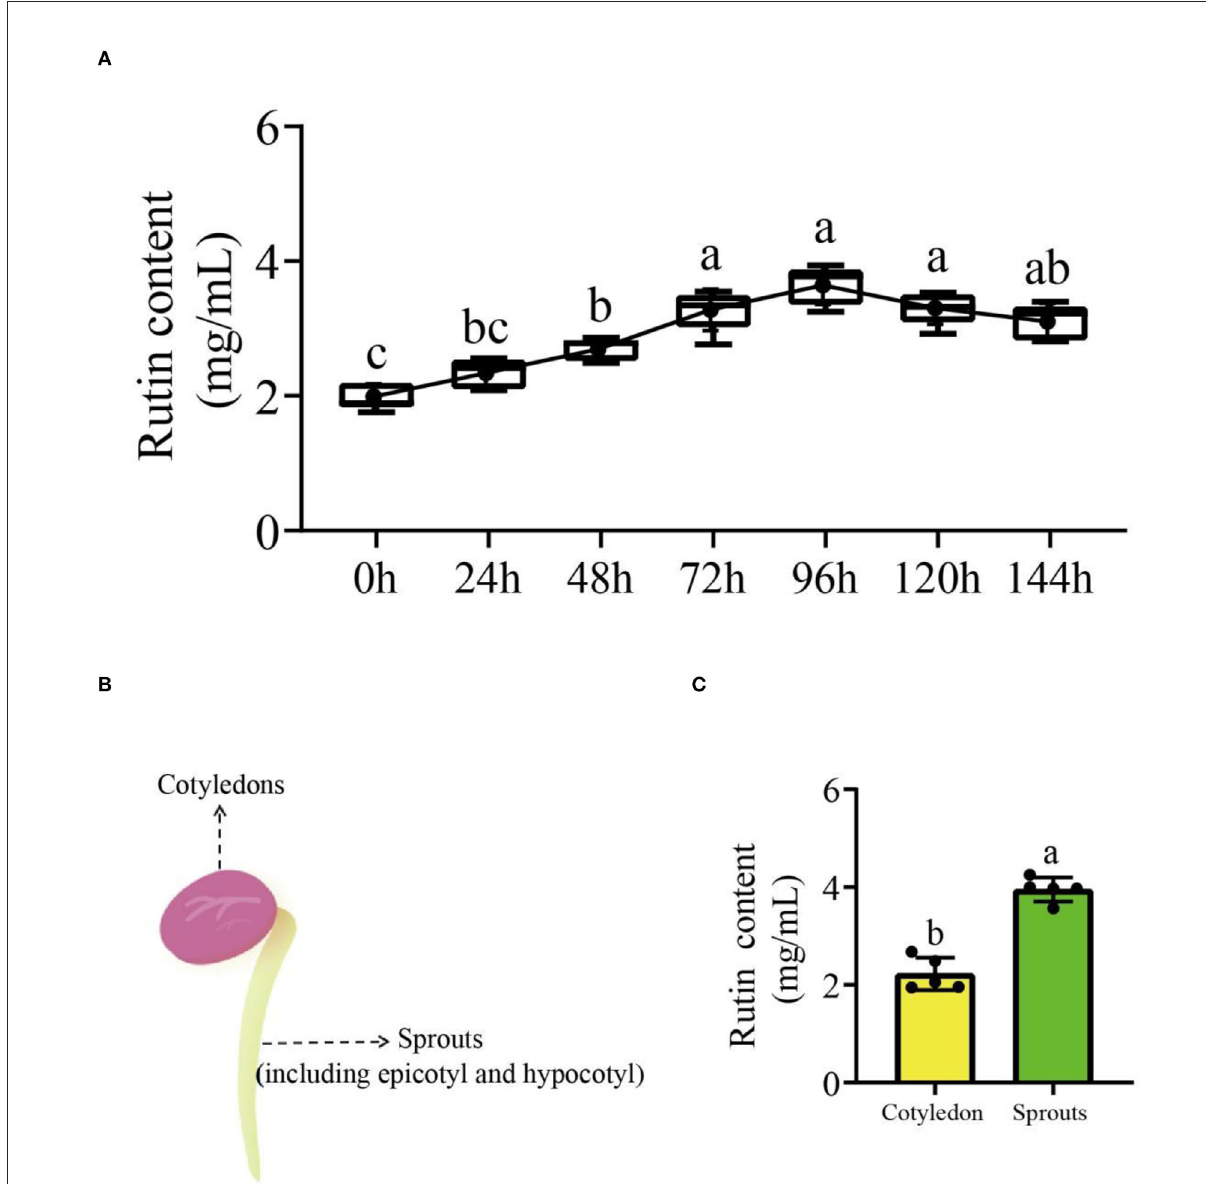
FIGURE1 The rutin accumulation trend in germinating common beans and tissue analyses. (A) The variation curve of rutin accumulation at different germination times; (B) schematic illustration of different tissues that were sampled; (C) the rutin content in different tissues of germinating common beans. Lowercase letter(s) indicate significant differences ( α = 0.05). Each black point represents the average value of